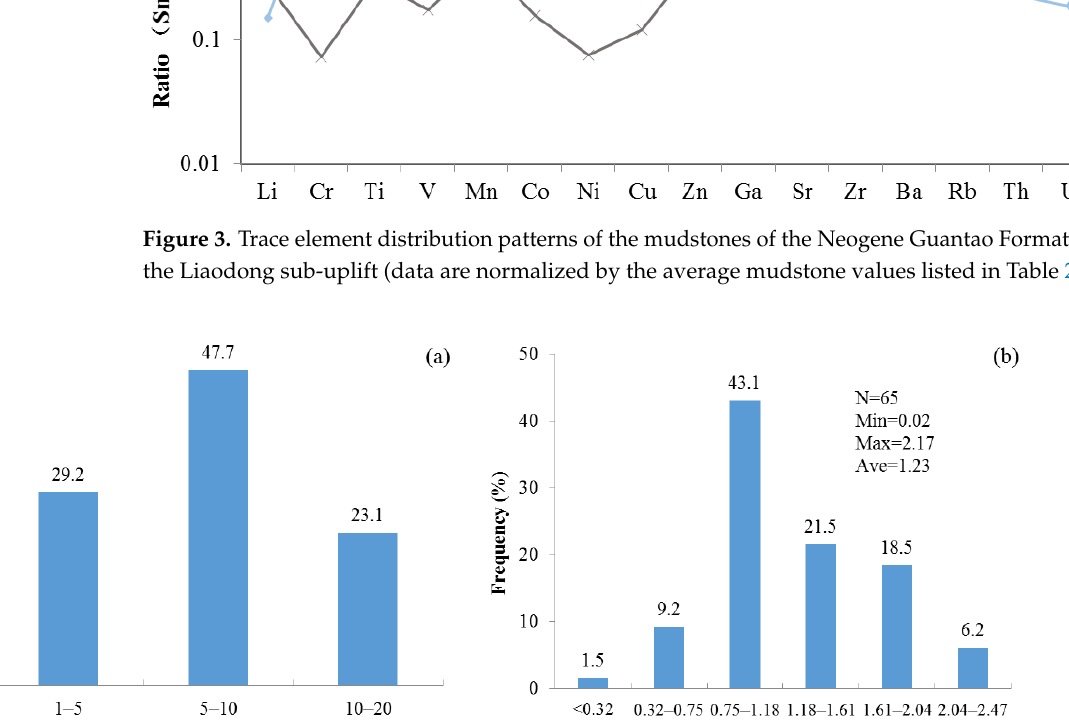
Figure 4. ( a ) Distribution histogram of Sr/Cu ratio. ( b ) Comparison diagram of Rb/Sr ratio of the Guantao Formation with the average marine mudstone and the mudstone of Eastern China.